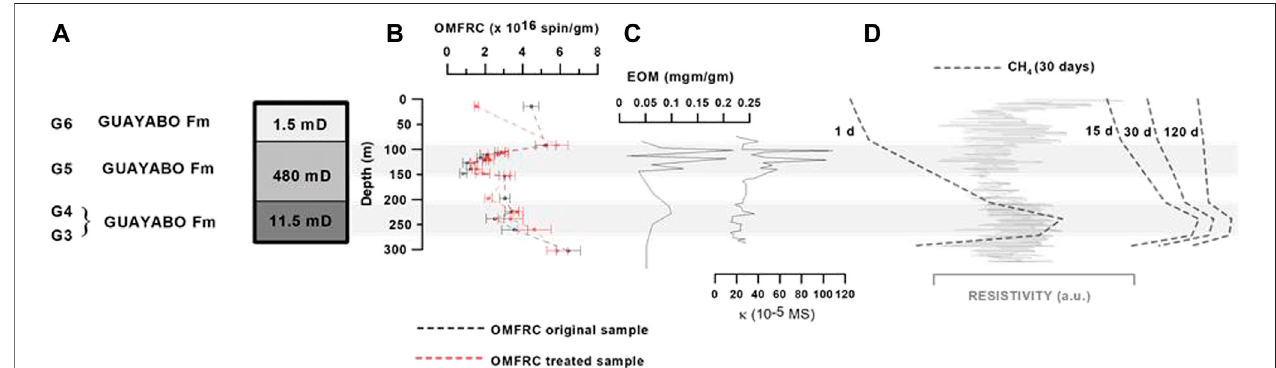
FIGURE 11 | Pro fi les corresponding to the upper Guayabo Formation in Saltarin 1A (i.e., units G3/G4, G5, and G6) that compare: (A) Control sequence (B) Concentrations of organic matter free radicals (chloroform-treated and untreated samples) for the depth interval between 0 and 300 m (C) EOM and magnetic susceptibilityanomaliesfrom Figures3A,C foradepth intervalbetween100and300 m corresponding toanear-surfacereducingzonethatcoincideswithavoid inthe OMFRC pro fi le. (D) Upper (0 and 300 m) section of the resistivity type-log in arbitrary units (a.i.) for the Eastern Llanos Basin compared with the modeled methane pro fi le (control sequence 1, 15, 30 and 120 days). The gray stripes show the two depth intervals in which redox reactions appear to be triggered (i.e., G3/G4) and reach the maximum generation of EOM and Fe-oxides and/or sul fi des (upper G5).